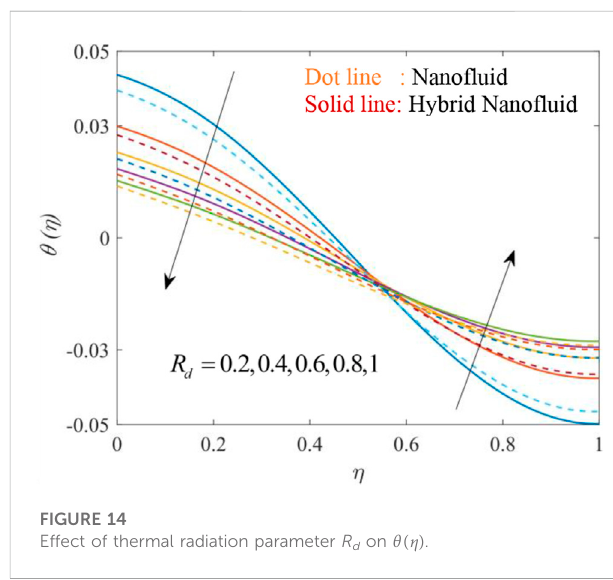
FIGURE 14 Effect of thermal radiation parameter R d on θ ( η )